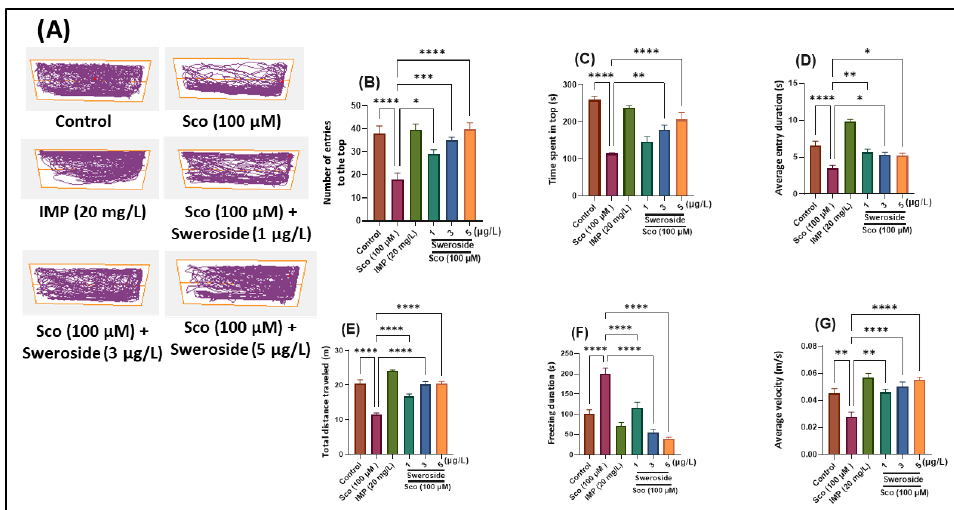
Figure 1. NTT results for sweroside (2.79, 8.35, and 13.95 nM). ( A ) Representative tracking locomotion patterns in various groups; ( B ) Number of entries to the top; ( C ) Time spent in top (s); ( D ) Average entry duration (s); ( E ) Total distance traveled (m); ( F ) Freezing duration (s); and ( G ) Average velocity (m/s). Data are presented as means ± S.E.M. ( n = 10 animals per group). * p < 0.01, ** p < 0.001, *** p < 0.0001, and **** p < 0.00001 (Tukey’s post hoc analyses). Imipramine (IMP, 63.11 μ M) was used as a reference positive drug.